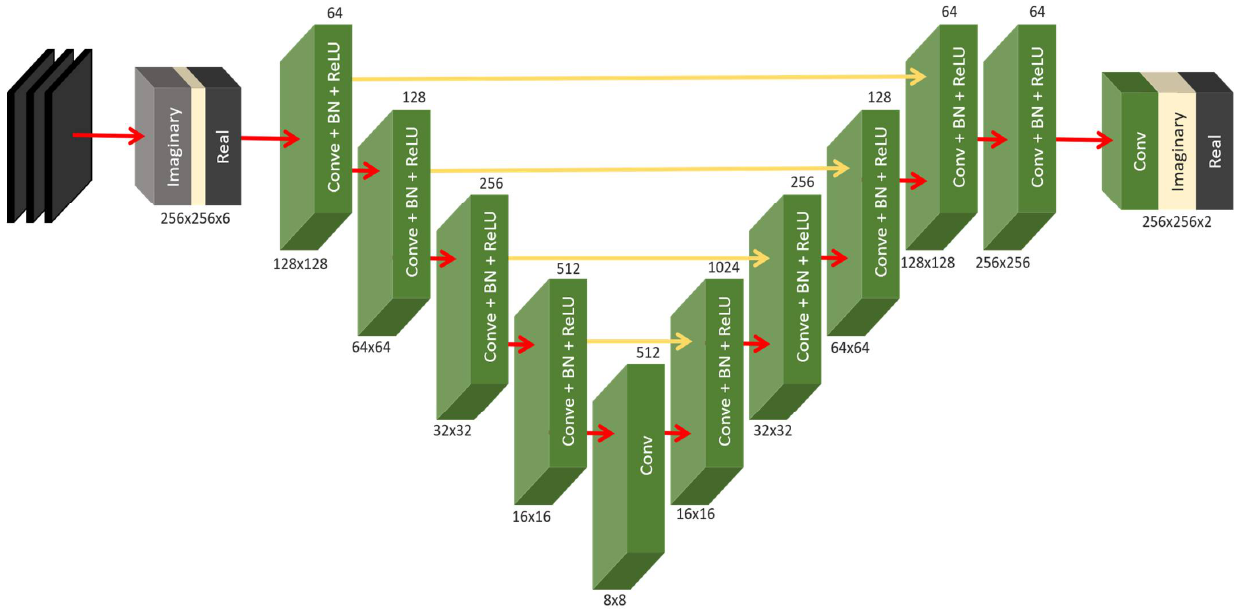
Figure 3. Generator architecture. Figure 3. Discriminator